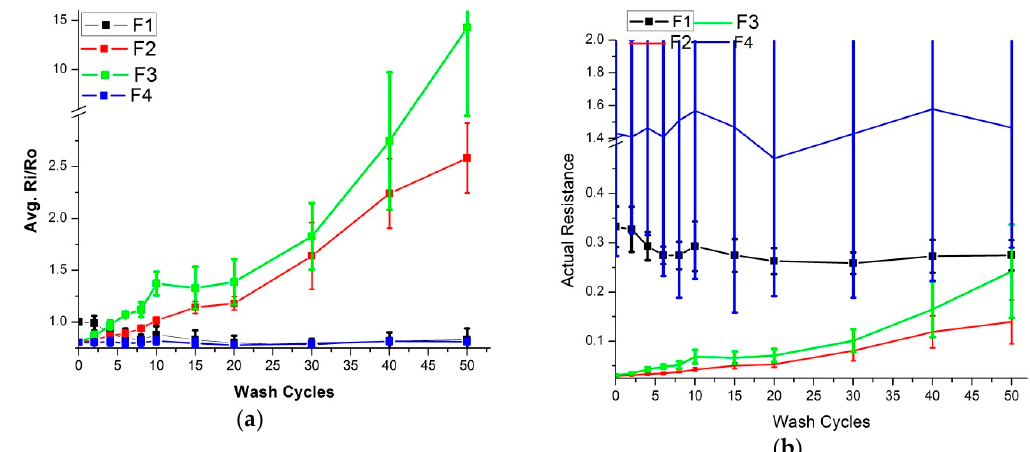
Figure 3. Surface resistance analysis (silk wash). ( a ) Comparison of Ri/Ro ( b ) Comparison of actual surface resistance.